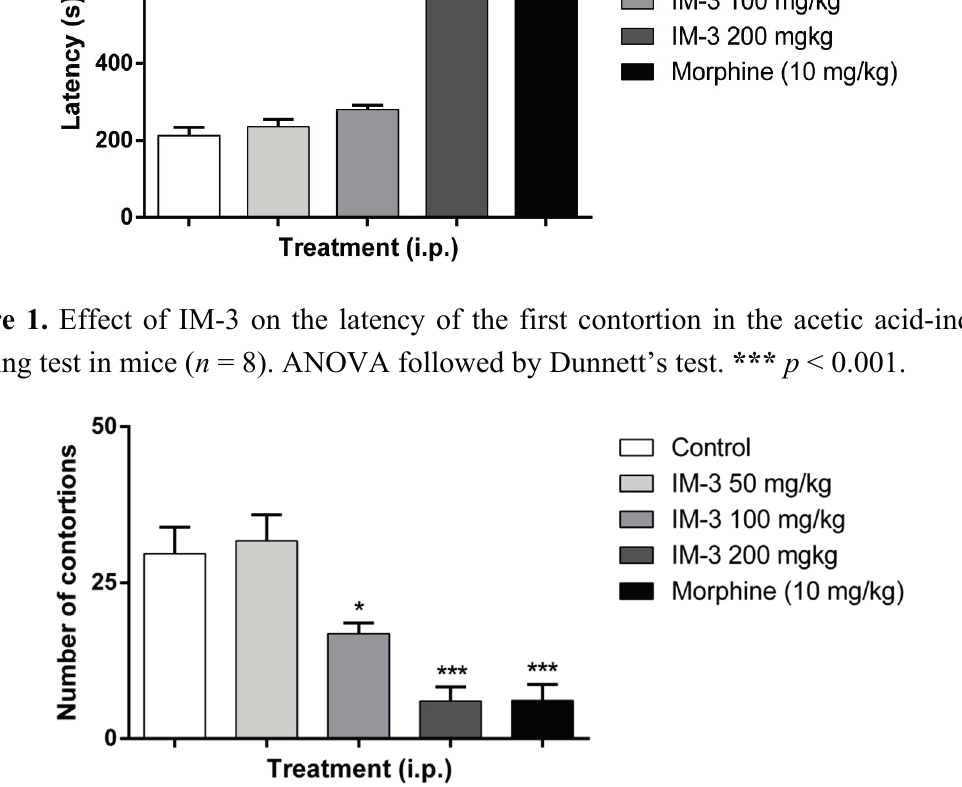
Figure 2. Effect of IM-3 on the number of contortions in the acetic acid-induced writhing test in mice ( n = 8). ANOVA followed by Dunnett’s test. * p < 0.05, *** p <